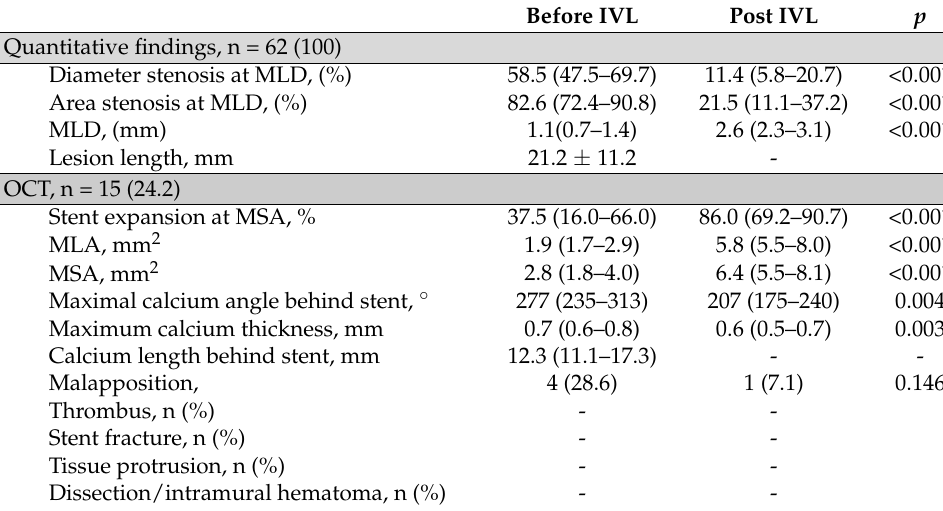
Figure 2. Cumulative frequency distribution curves demonstrating increased lumen diameter and lumen area at baseline and post Shockwave Intravascular Lithotripsy (IVL) percutaneous coronary intervention (PCI) calculated by quantitative coronary angiography (QCA). ( A , B ) Stenosis of the lumen diameter ( C , D ) Stenosis of the lumen area. Table 3. Quantitative findings and intracoronary